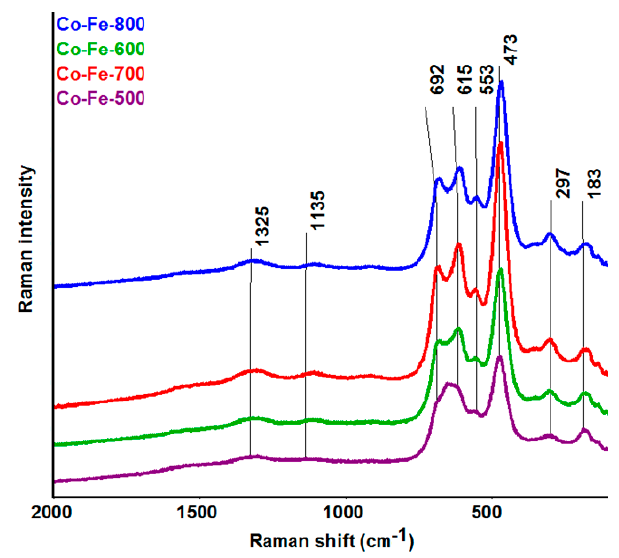
Figure 8. Raman spectra of CoFe 2 O 4 nanoparticles prepared at various temperatures. Table 1. Measured Raman shifts of CoFe 2 O 4 nanoparticles.